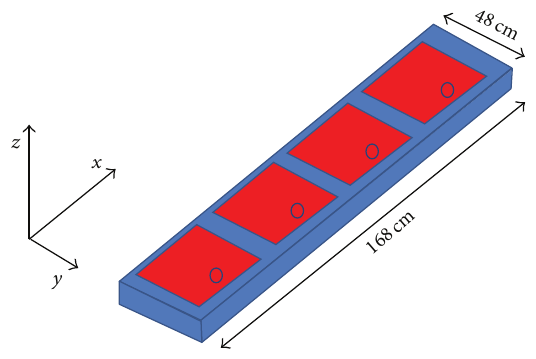
Figure 4: SAR antenna configuration.